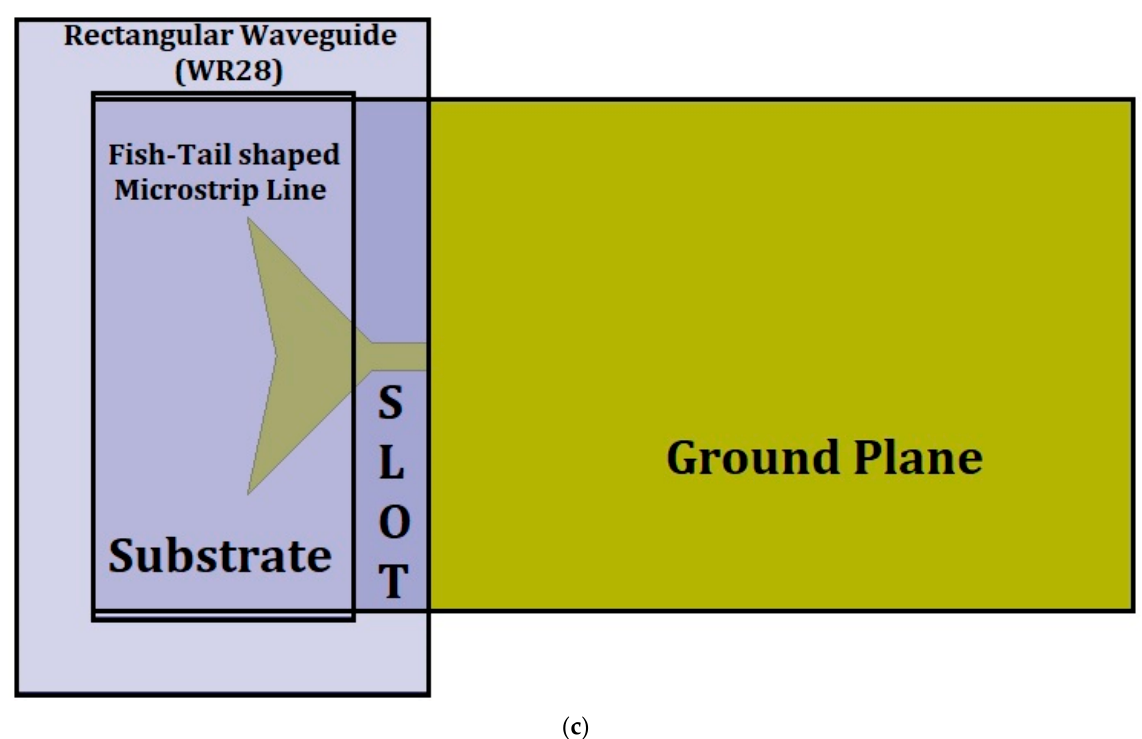
Figure 2. ( a ) Fish-tail-shaped microstrip line. ( b ) Fish-tail-shaped microstrip line top view strip conductor. ( c ) Fish-tail-shaped microstrip line bottom view ground.